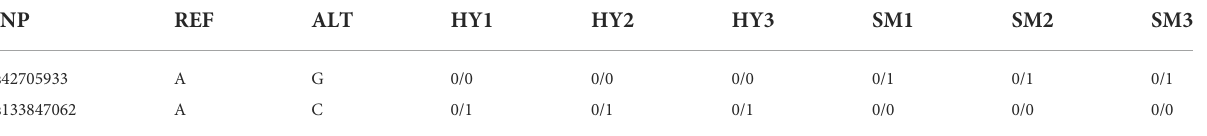
TABLE 3 Genotypes of SNP rs42705933 and rs133847062 in two